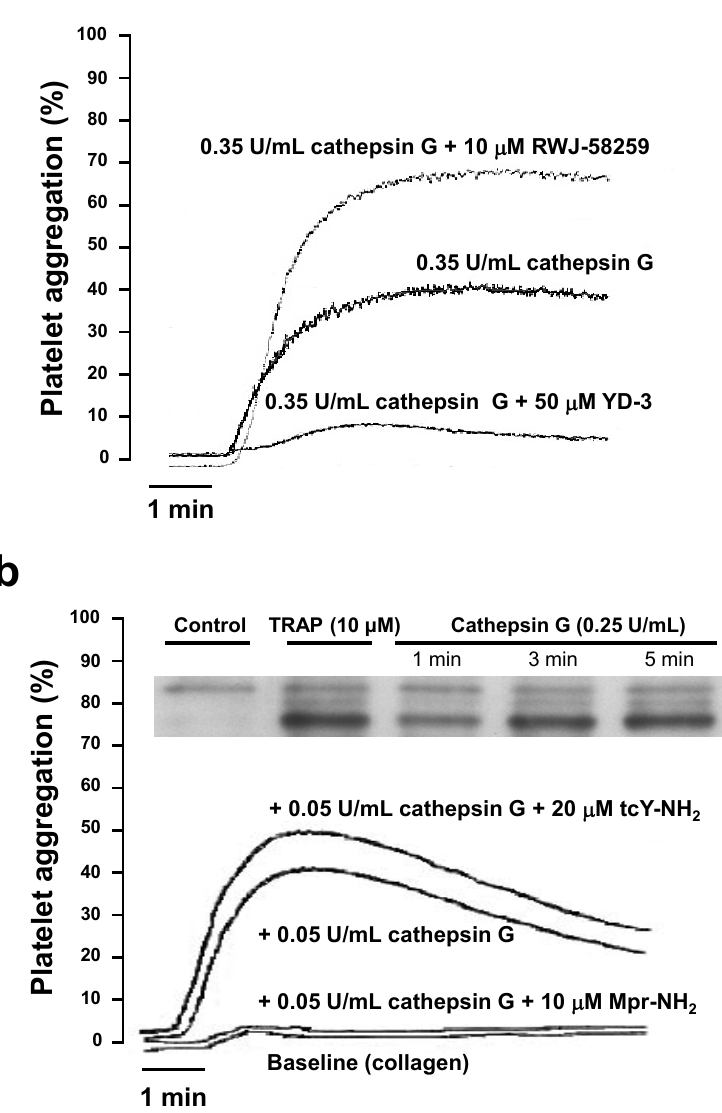
Figure 2. Washed human platelet aggregation: Role of PAR1 and PAR4. ( a ) Washed human platelet aggregation tracings by 0.35 U/mL cathepsin G, in the absence or presence of the PAR1 antagonist